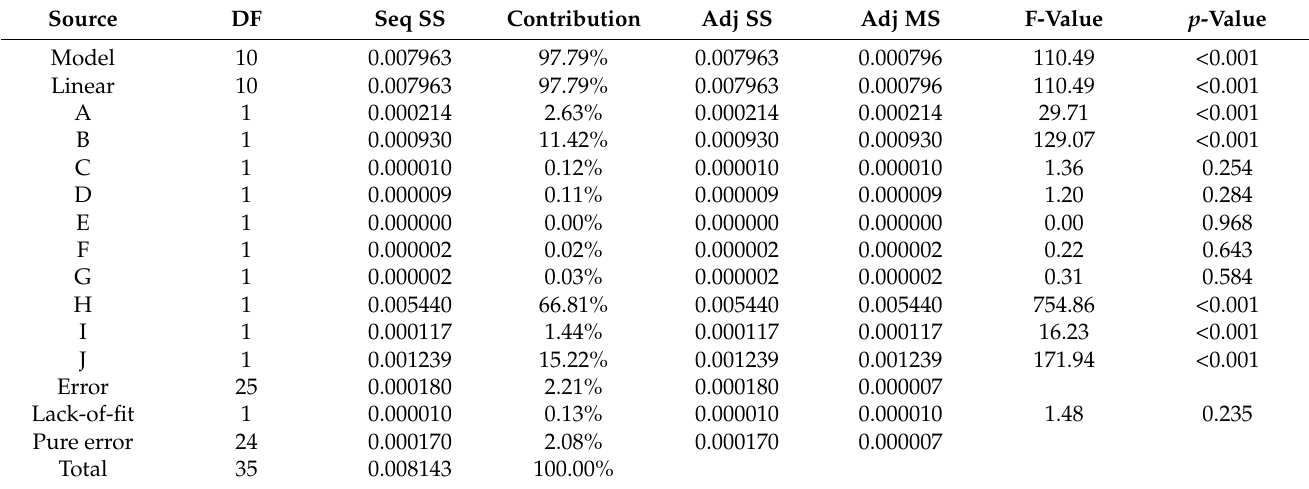
Table 8. The ANOVA table for the PB design of nitrogen sources.